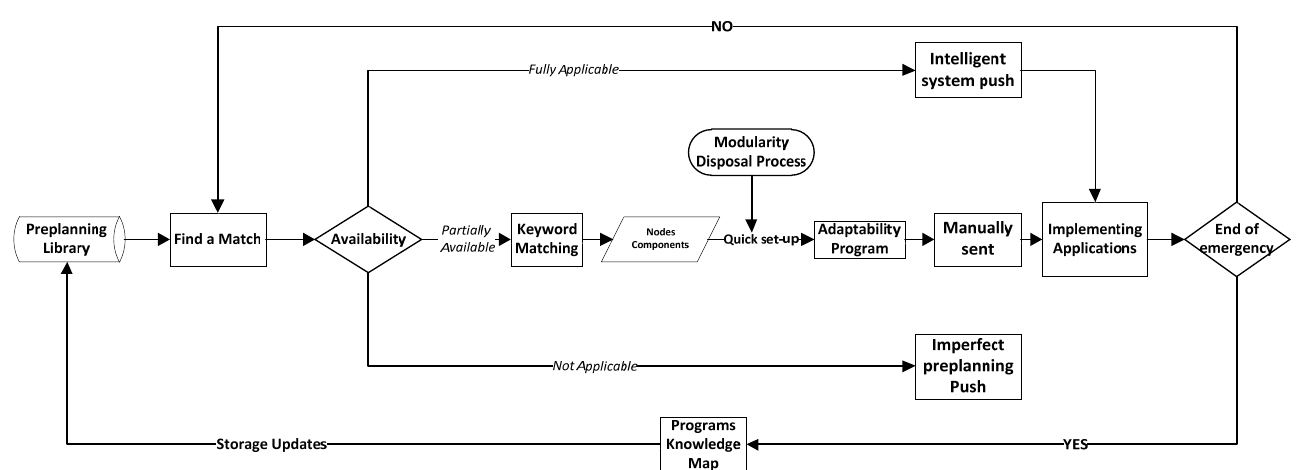
Figure 7. Modular standard disposal